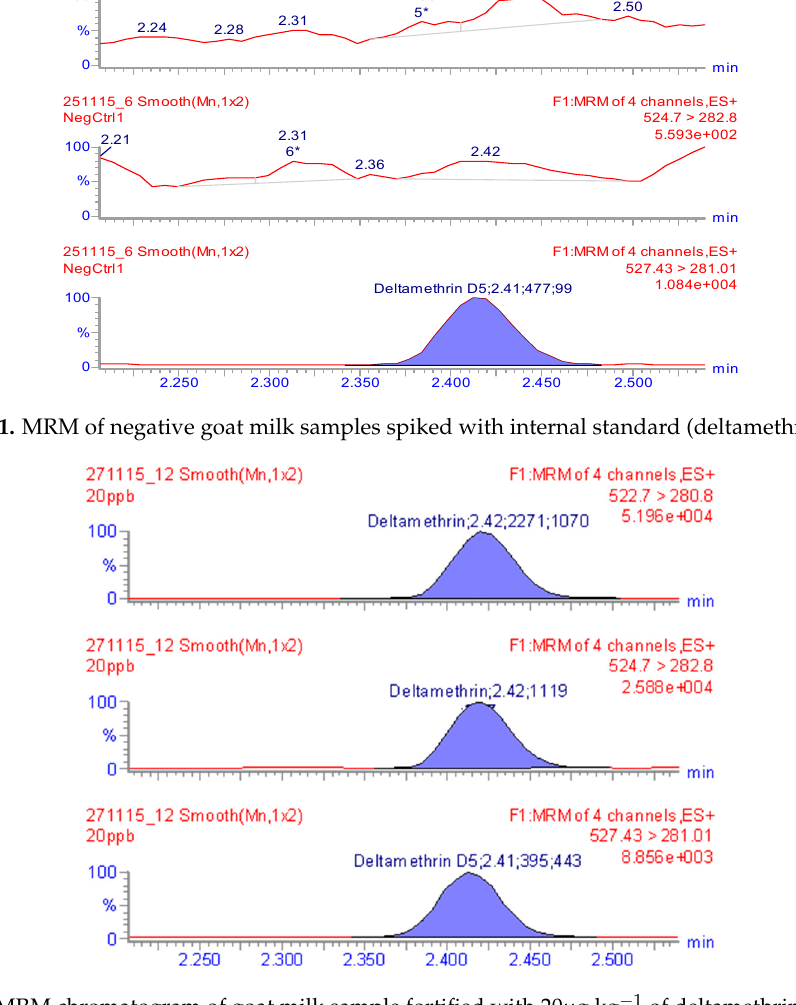
Figure 2. MRM chromatogram of goat milk sample fortified with 20 μ g kg − 1 of deltamethrin standard .